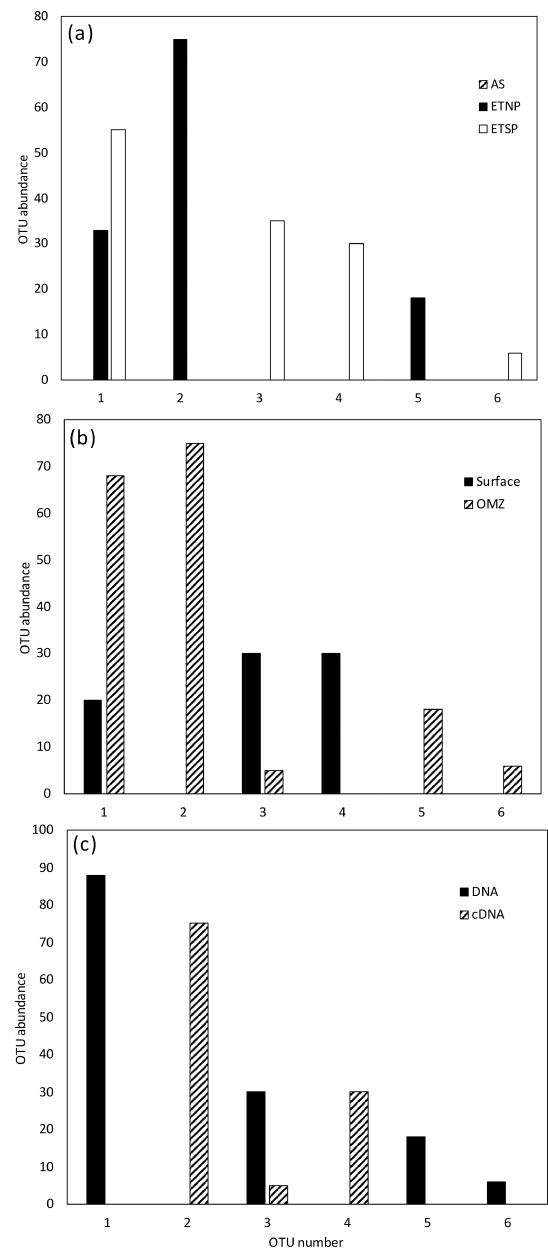
Figure 4. Histogram of the six most common OTUs from the Clus- ter II, III, and IV nifH clone libraries from the three OMZ regions. OTUs were considered common if the total number of sequences in an OTU was ≥ 2% of the total number of nifH clones analyzed (the common OTUs contained 252 of the 275 Cluster II, III, and IV se- quences). OTUs were defined according to 3% nucleotide sequence difference using the furthest-neighbor method. OTU designation is from most common (OTU-1) to least common. (a) OTU distribu- tion among regions. (b) OTU distribution between OMZ (including core of the ODZ and the upper oxycline depths) and surface depths (oxygenated water). (c) OTU distribution of cDNA vs. DNA